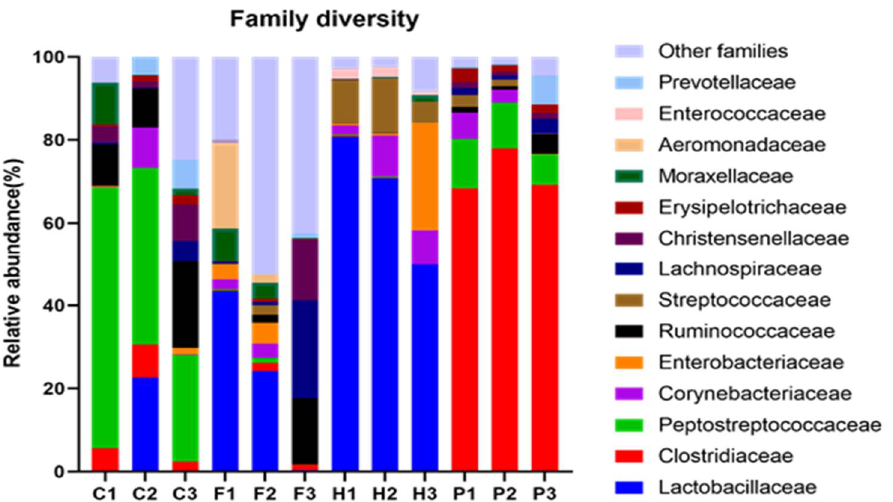
Figure 2. Relative Abundance of Sequences Representing Families Constituting Bacterial Commu- nities in Different Animal Manure